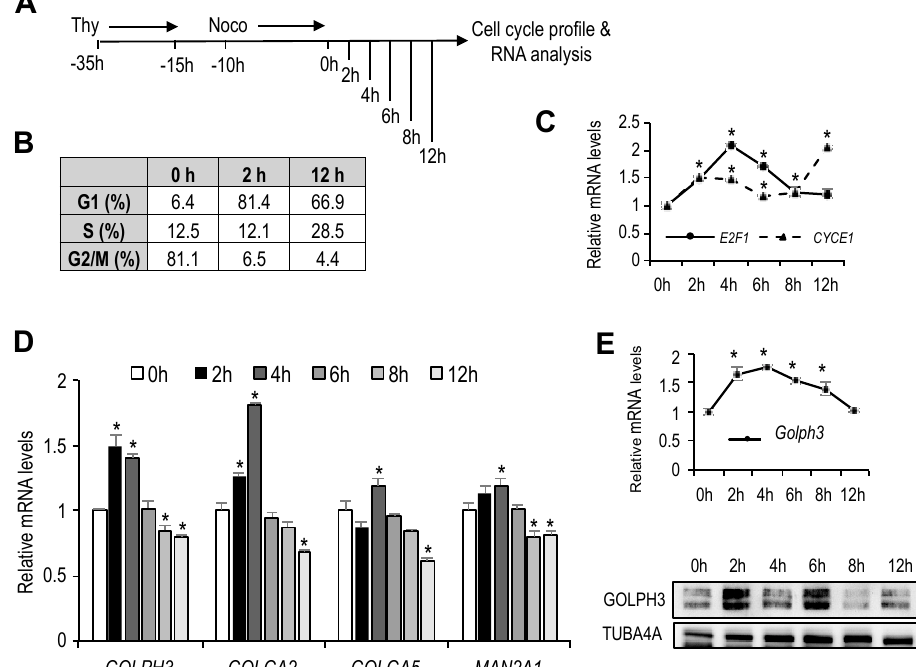
Figure 1. Expression of genes encoding Golgi-specific proteins in the cell cycle. ( A ) As shown in the schematic diagram, U2OS cells that had been treated with thymidine (Thy) for 20 h were washed and 5 h later were treated with nocodazole (Noco) for 10 h to synchronize in mitosis. Subsequently, cells were released into the cell cycle and collected at the indicated time-points for cell cycle profiling and RNA analysis. ( B ) Table showing the percentage of cells in each cell cycle phase at the indicated time-points, as assessed by FACS analysis of PI-stained cells. ( C , D ) Reverse transcriptase-quantitative PCR (RT-qPCR) analyses of indicated genes is shown. Expression values were normalized to the expression of EIF2C2 , used as standard control. Data are represented as fold-change (mean + SD) relative to samples synchronized in mitosis (0 h). Shown are the results of one representative experiment of three independent experiments. ( E ) RT-qPCR analysis of mouse GOLPH3 mRNA. Mouse NIH 3T3 cells that had been synchronized in G0 by serum starvation were released into the cell cycle after serum addition. RNA samples were collected at the indicated time-points. Expression values were normalized to the expression of EIF2C2 , used as standard control. Graph represents the relative expression values of GOLPH3 messenger RNA (mRNA) relative to cells in G0 (0 h). ( F ) Western analysis of thymidine-nocodazole synchronized U2OS cells showing GOLPH3 expression after release from mitosis (0 h). *, p < 0.05.